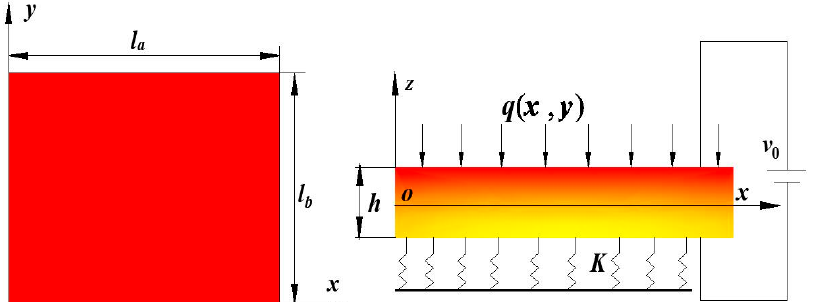
Figure 1. Functionally graded piezoelectric plate on elastic foundation.